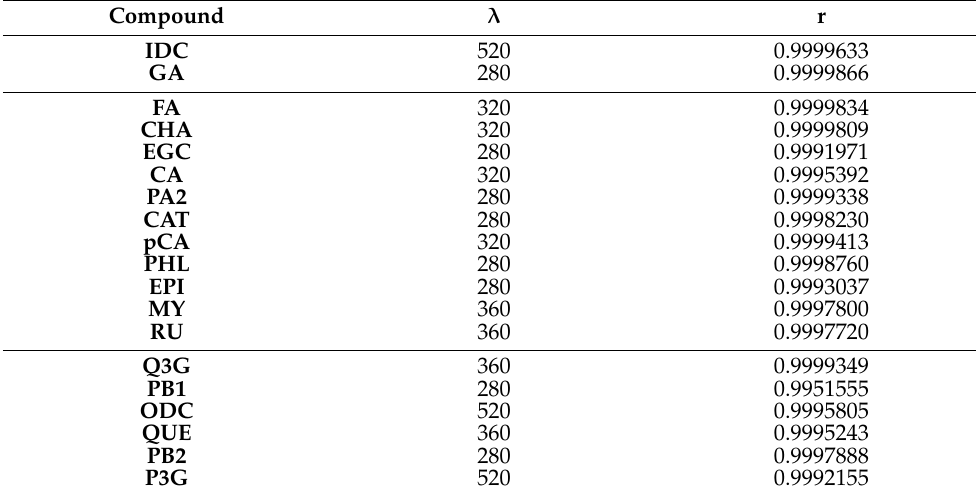
Table A3. Detection wavelengths and correlation coefficients (r) calculated from the linear regression equations for the tested components.